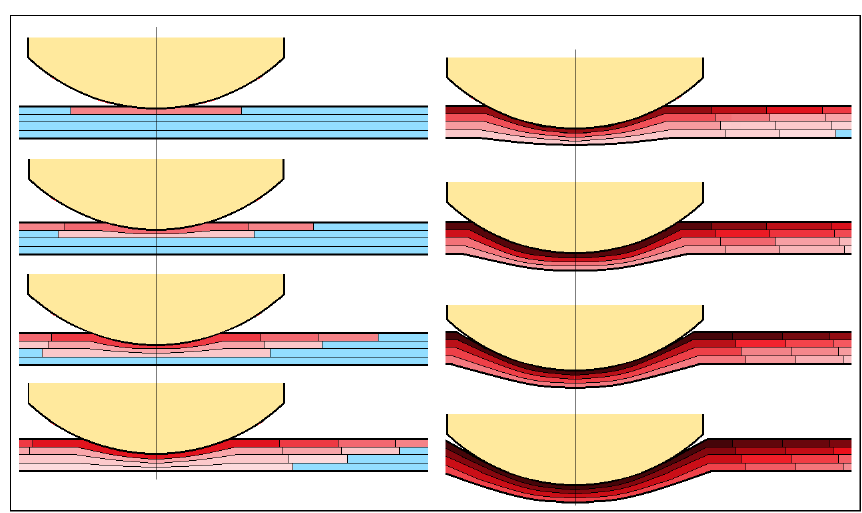
Figure A2. Curved surface (saddle) projectile distortion process in the impacted yarn in the first few microseconds after impact, including effect of tensile wave collision under the projectile.